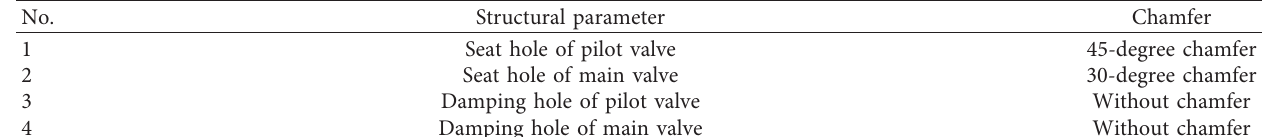
Table 4: Internal structure of relief valve.